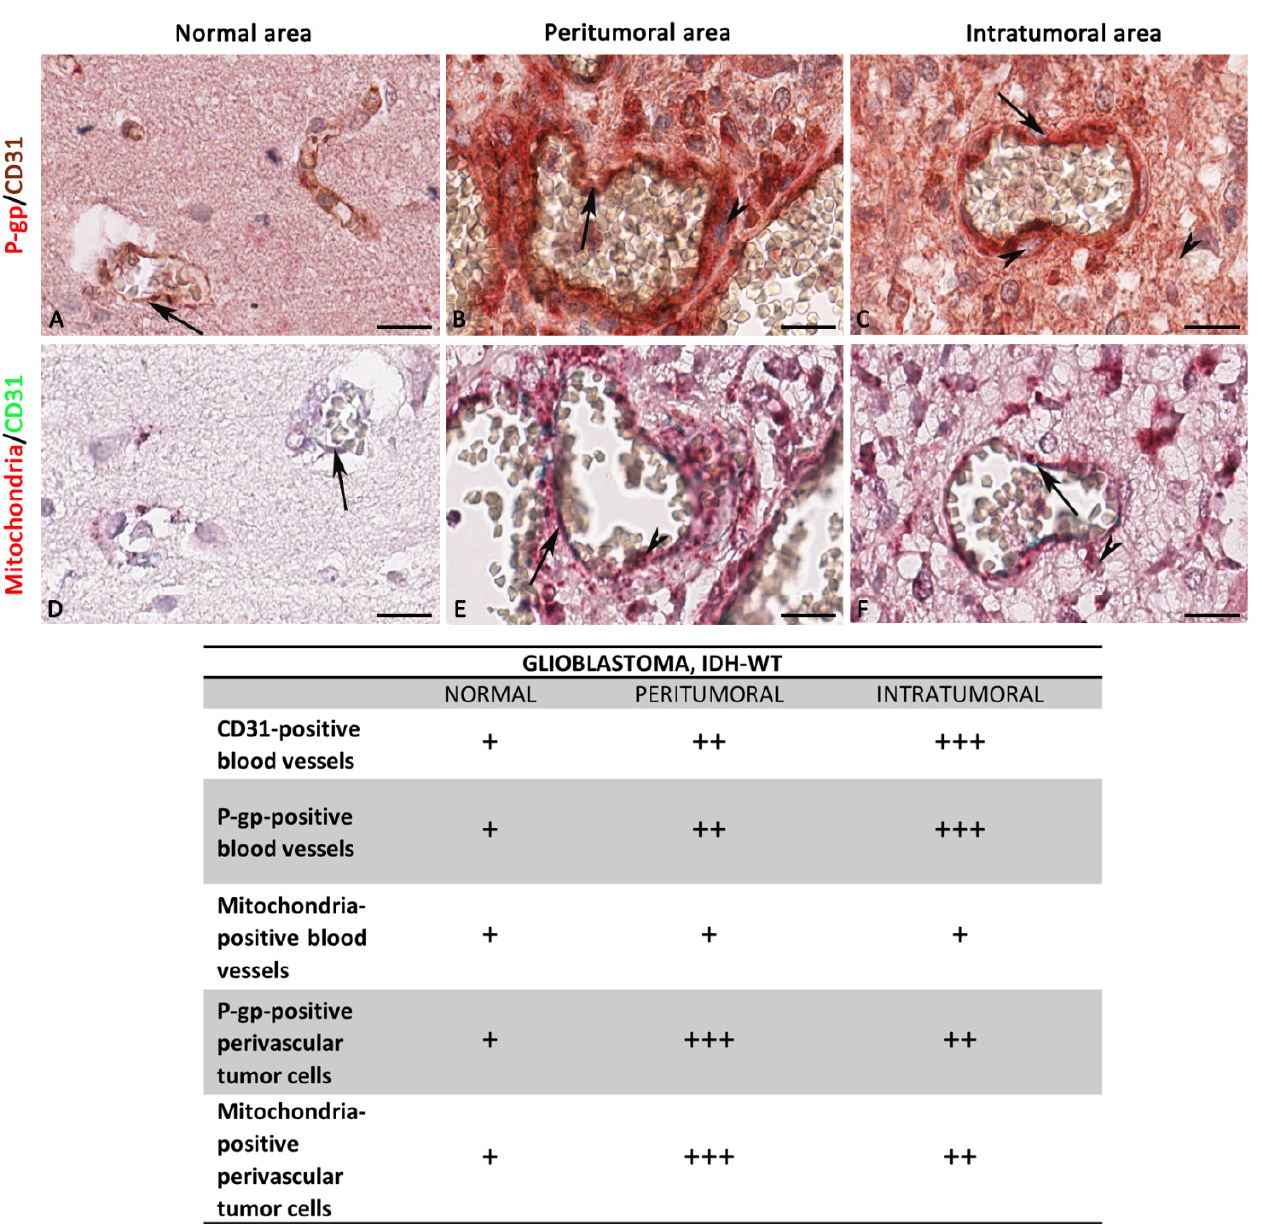
Figure 9. Focus on IDH-WT glioblastoma blood vessels and tumor cells. High magnification of P-gp, mitochondria, and CD31 immunohistochemistry reactions, within the same spatial ROIs on IDH-WT glioblastoma serial sections, and the summary table below show the differential expression of these markers by ECs and tumor cells. P-gp ( A – C ) and mitochondria ( D – F ) expression by tumor cells are increased in the peritumoral area compared with the others. CD31 and P-gp ( A – C ) expression by ECs are increased in the intratumoral area compared with the others. The table shows the semi-quantitative scoring of IHC reactivity: “/“, very weak or absent; “+”, weak; “++”, intermediate; “+++”, strong. Arrows: ECs; arrowheads: tumor cells. Scale bar: ( A – F ) 16 μ m.